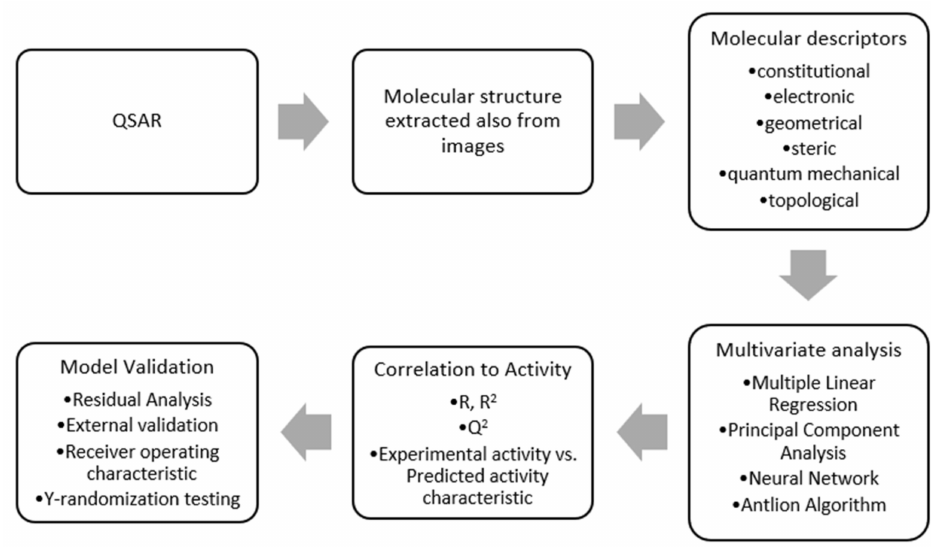
Figure 4. Workflow for chemical model